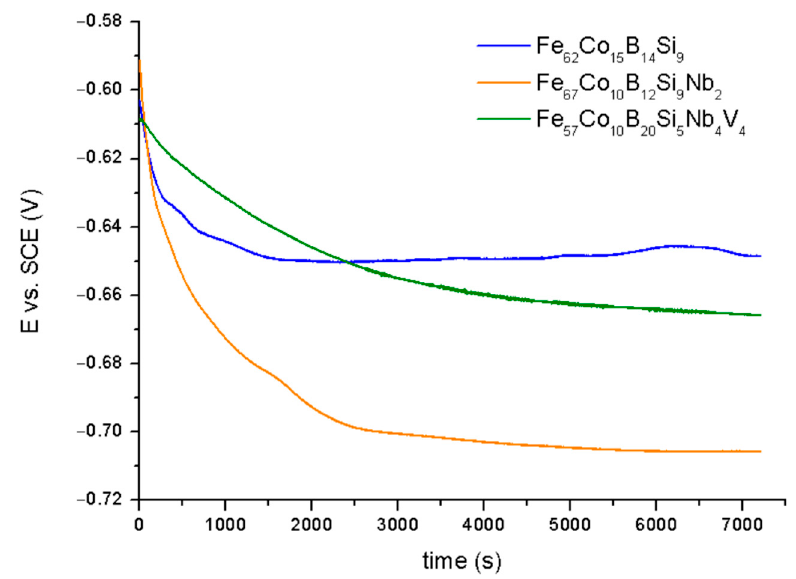
Figure 5. The OCP curves for samples in 0.5 M NaCl.